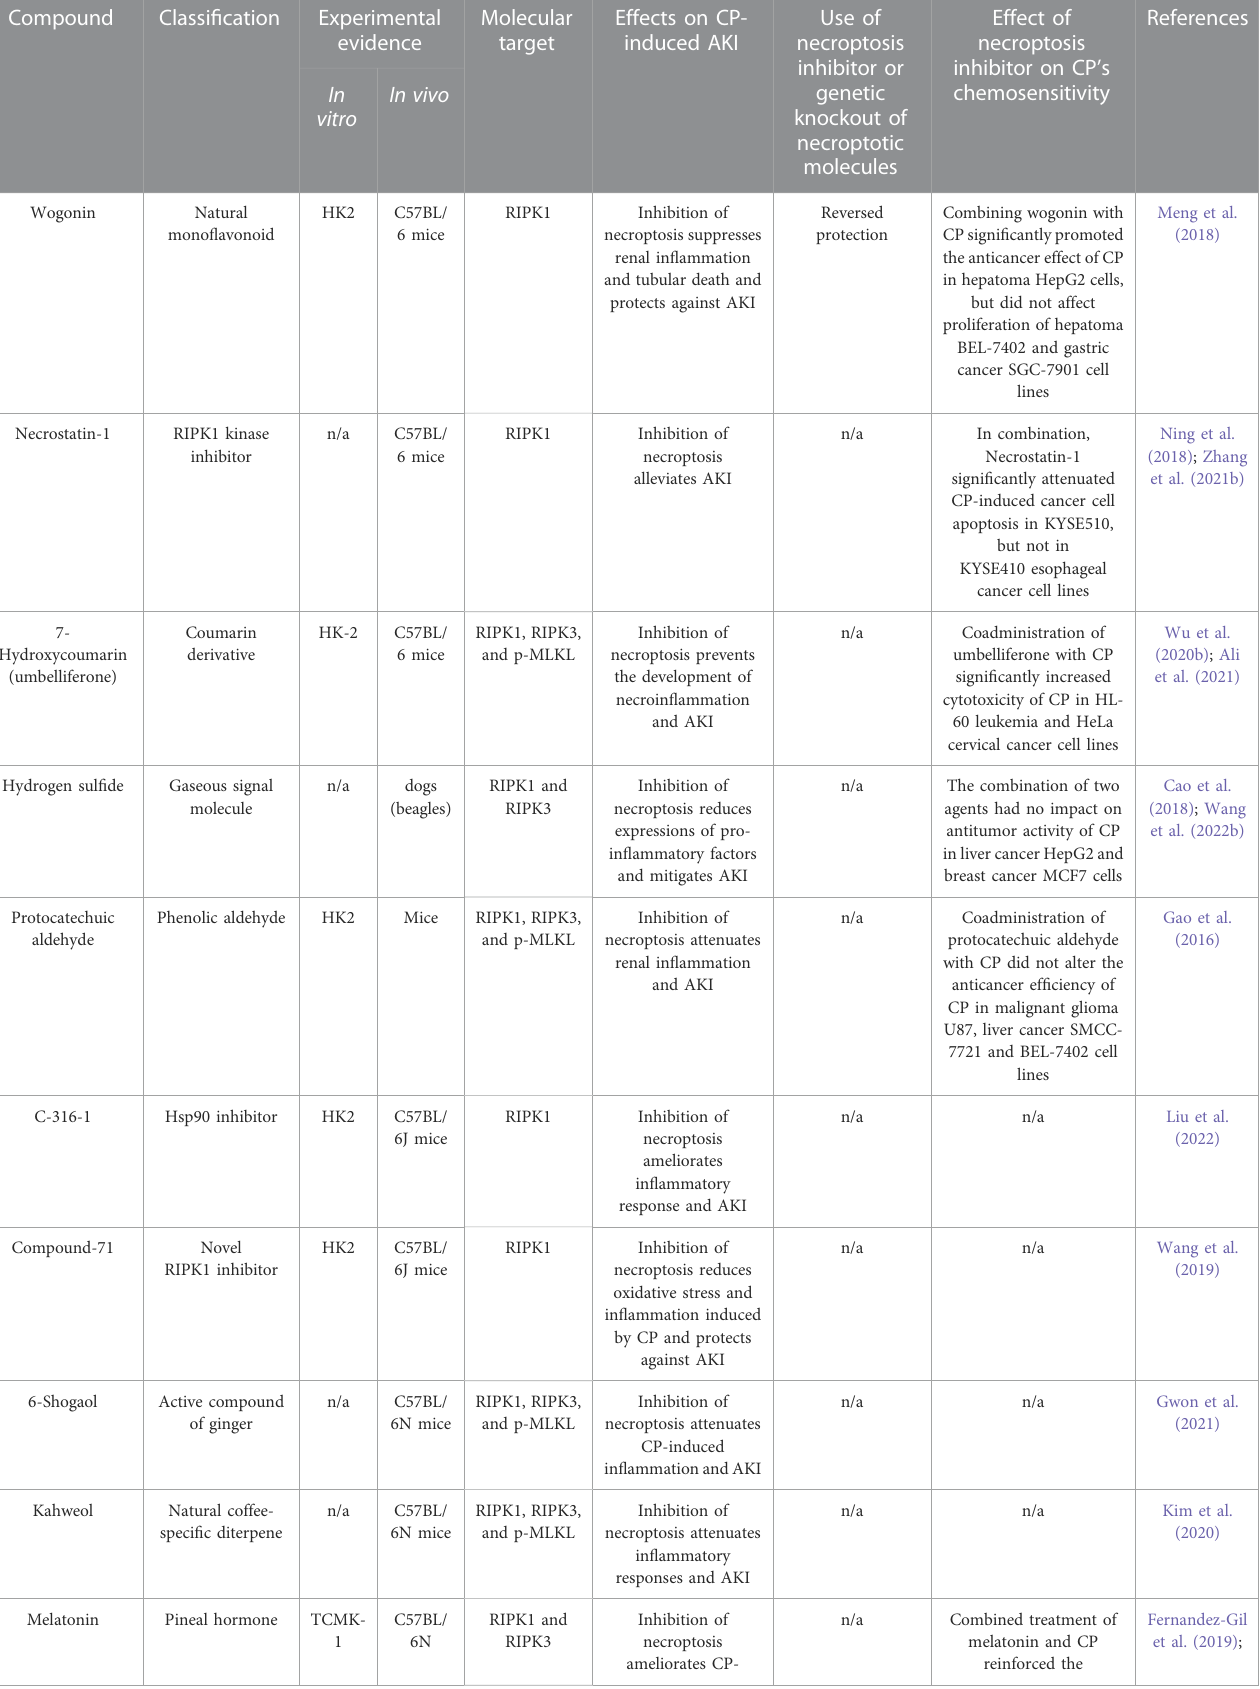
TABLE 1 Summary of molecules targeting necroptosis in CP-induced